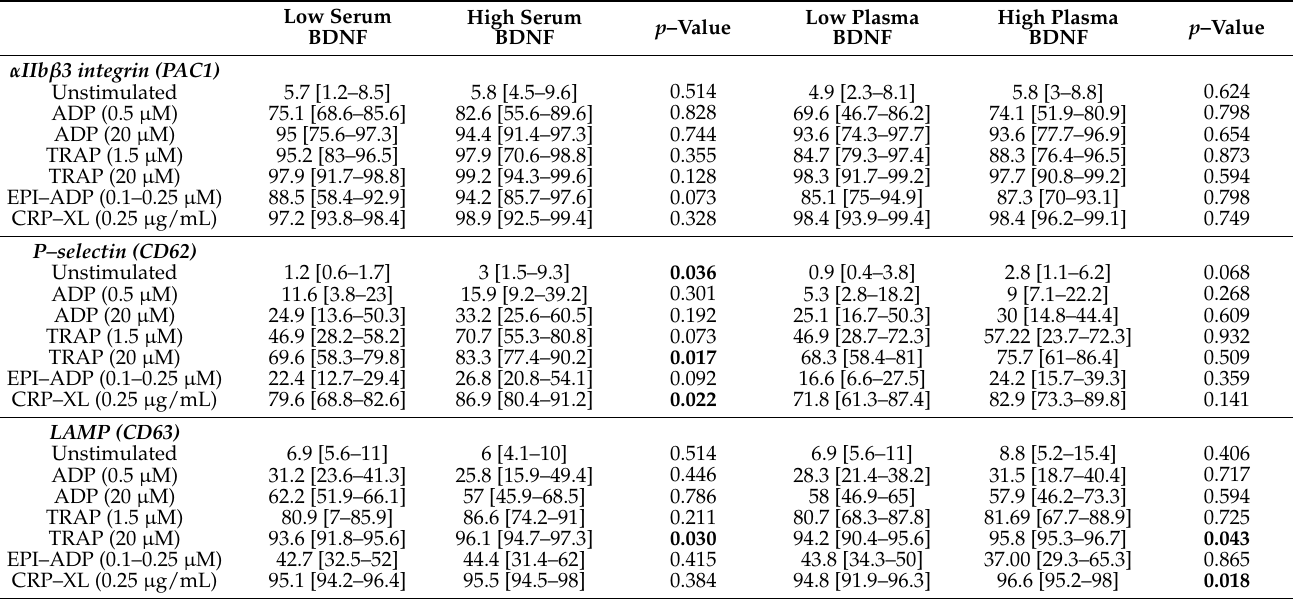
Figure 1. Correlation of serum BDNF levels with ( a ) platelet count, ( b ) unstimulated platelet P-selectin (CD62) expression and ( c – f ) stimulated platelet P-selectin (CD62) expression. Scatter plots are shown, with a regression line and a 95% confidence interval. BDNF, brain-derived neurotrophic factor; PLT, platelet count, ×10 9 /mL; TRAP, the protease-activated receptor (PAR)-1 agonist thrombin receptor activator peptide; ADP, adenosine diphosphate; EPI, epinephrine. Table 2. Platelet surface activated alphaIIbetaIII integrin, P-selectin and lysosomal-associated membrane protein (LAMP) expression in patients with high and low serum and plasma BDNF levels. Low Serum BDNF High Serum BDNF p –Value Low Plasma BDNF